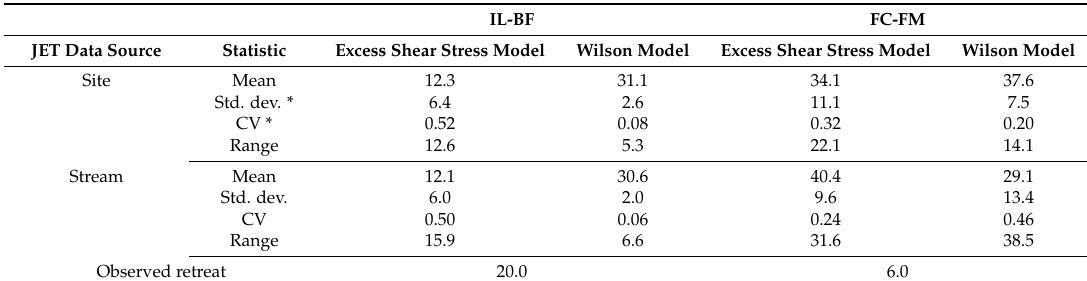
Table 4. Summary statistics for predicted lateral retreat (m) from CONCEPTS using JET results along Barren Fork Creek (IL-BF) and Fivemile Creek (FC-FM).